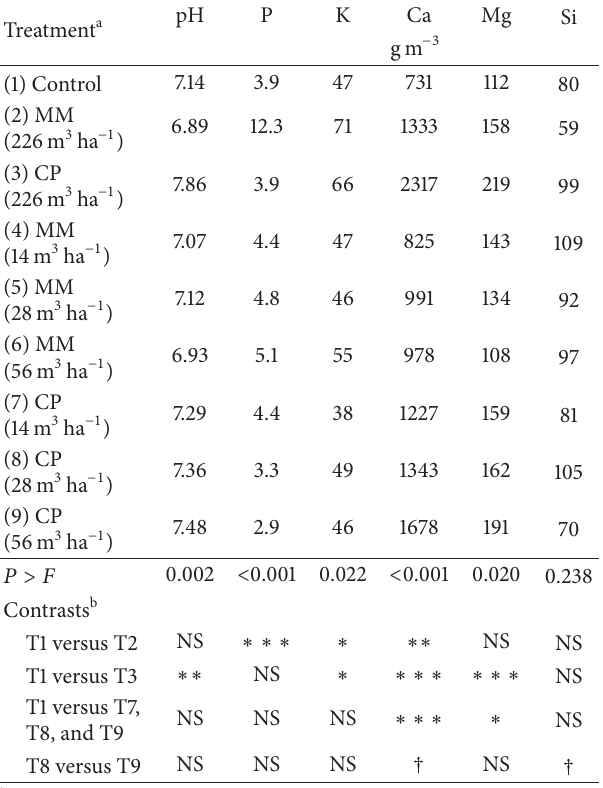
Table 9: Predicted least squares means, 𝑃 > 𝐹 , and significant contrasts for pH and soil-extractable nutrients (in row, 0–15cm depth) after the plant cane crop at Site 1.